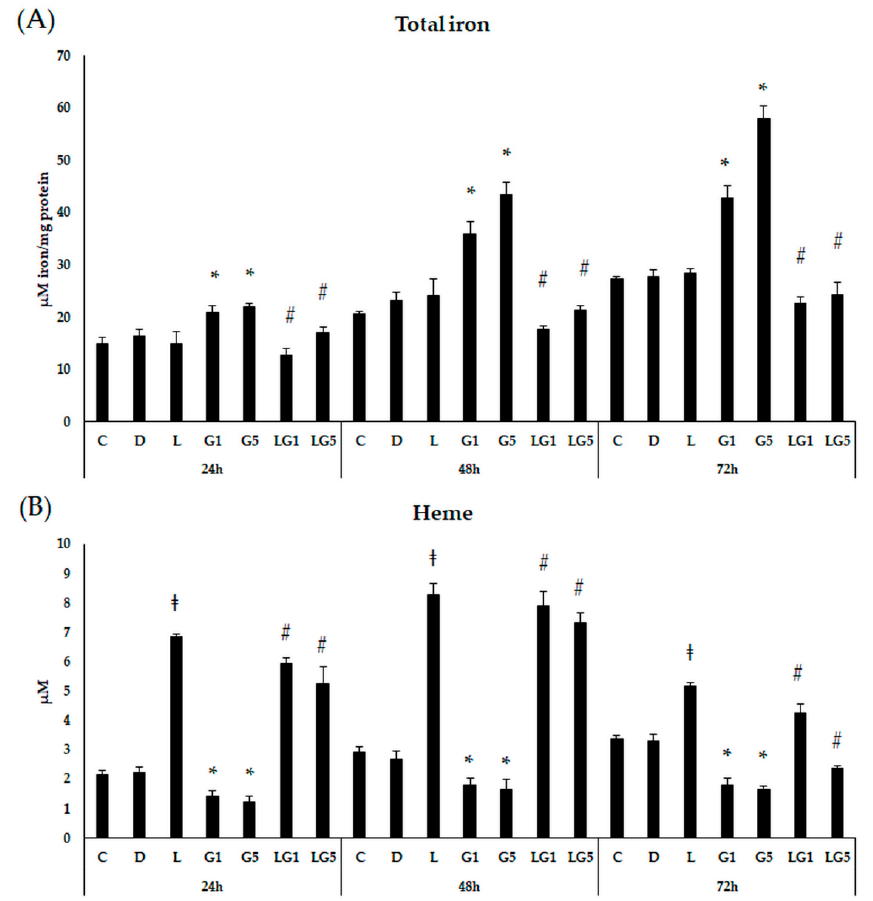
Figure 12. Determination of total iron levels ( A ) and heme concentrations ( B ) after lutein and Glu treatments of the SH-SY5Y cells. SH-SY5Y cells were treated with 10 ng/µL of lutein, 1 mM, 5 mM Glu, or lutein with Glu together to detect the changes in the iron content. The cells were incubated for 24 h, 48 h, and 72 h. A ferrozine-based colorimetric assay was used to perform the total iron measurements. The results of iron levels were normalised against the protein concentration and were expressed as µM iron/mg protein. For the heme measurements, a Heme Assay kit was used. The concentration of heme was expressed as µM. The bars represent the mean values (±standard deviation error bars, SD) of three independent experiments ( n = 3) performed in triplicate and are presented relative to their control cells. The * marks the statistical significance of Glu treatments compared to control, ǂ signs the statistical significance of lutein treatments compared to control, # shows the statistical significance of combined (lutein with Glu) treatments compared to the Glu treatments at 24 h, 48 h and 72 h ( p < 0.05).